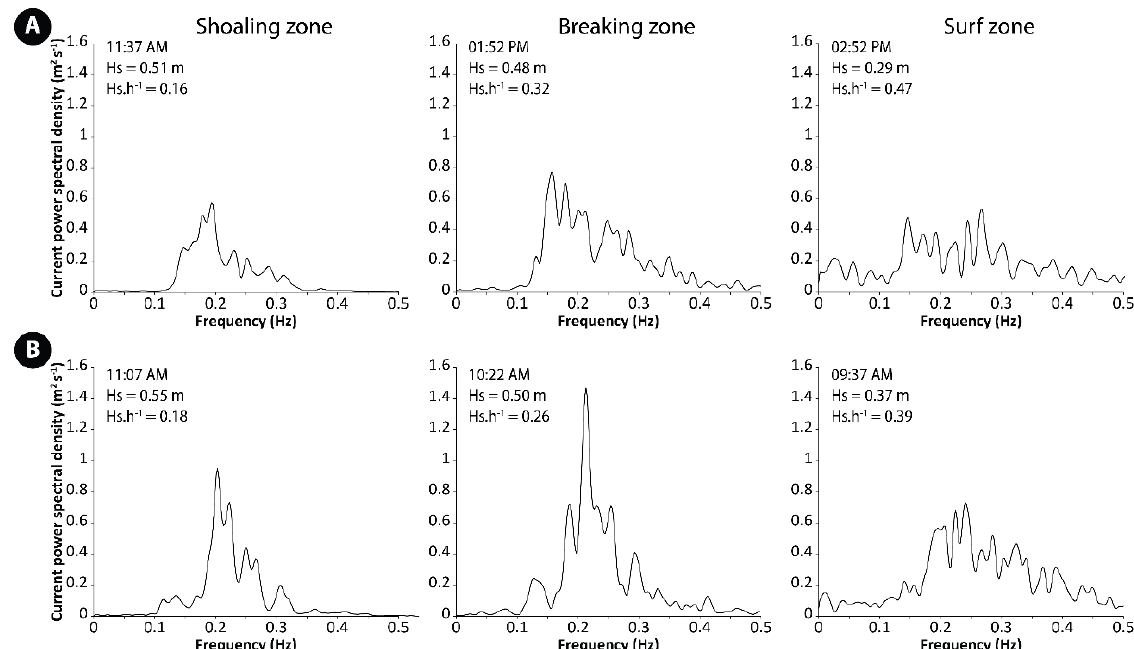
Figure 10. Examples of cross-shore current power density spectra obtained from current data recorded on bar B3 (see Figure 2D for location) under different wave processes (shoaling, breaking and surf) during ( A ) falling tide on 4 June 2013 (high tide at 10:30 AM and low tide at 05:30 PM) and ( B ) rising tide on 6 June 2013 (low tide at 07:00 AM and high tide at 12:15 PM).